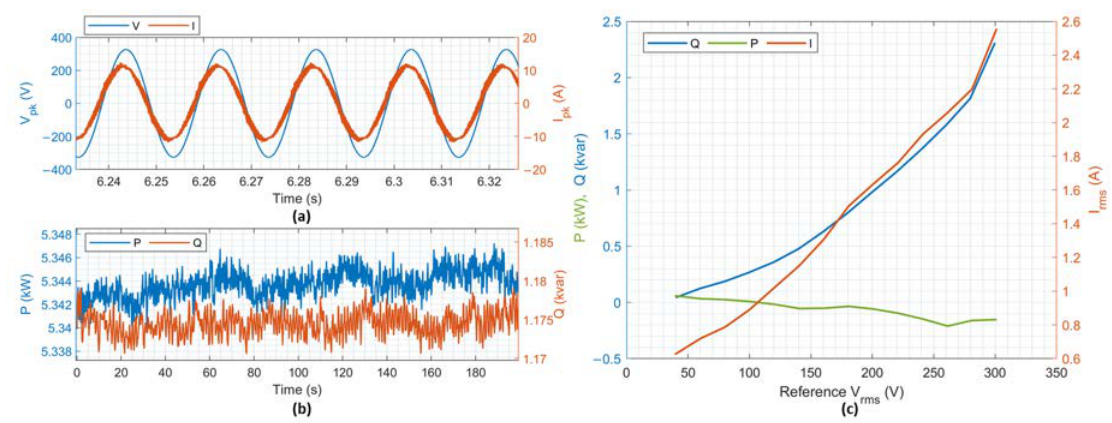
Figure 12. Response of the hardware under test (HUT). ( a ) Waveforms depicting phase difference between voltage and current for a pure active power demand. ( b ) Power flow of the hardware under test (HUT) as experienced by the virtual grid. ( c ) Dynamic behavior of the hardware under test (HUT) with variation in reference voltage (V ref ) to examine internal parasitic capacities.